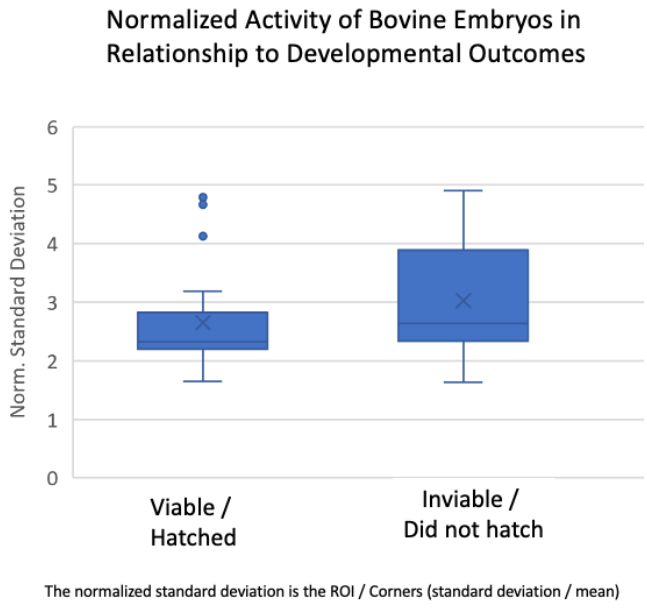
Figure 9. Normalized activity of bovine embryos in relation to developmental outcomes. Normalized activity (standard deviation/mean) was calculated for each of the embryo’s change over time. The X represents the mean of the normalized activity. Bars represent the range of the data and whiskers represent standard deviation ( p < 0.05).